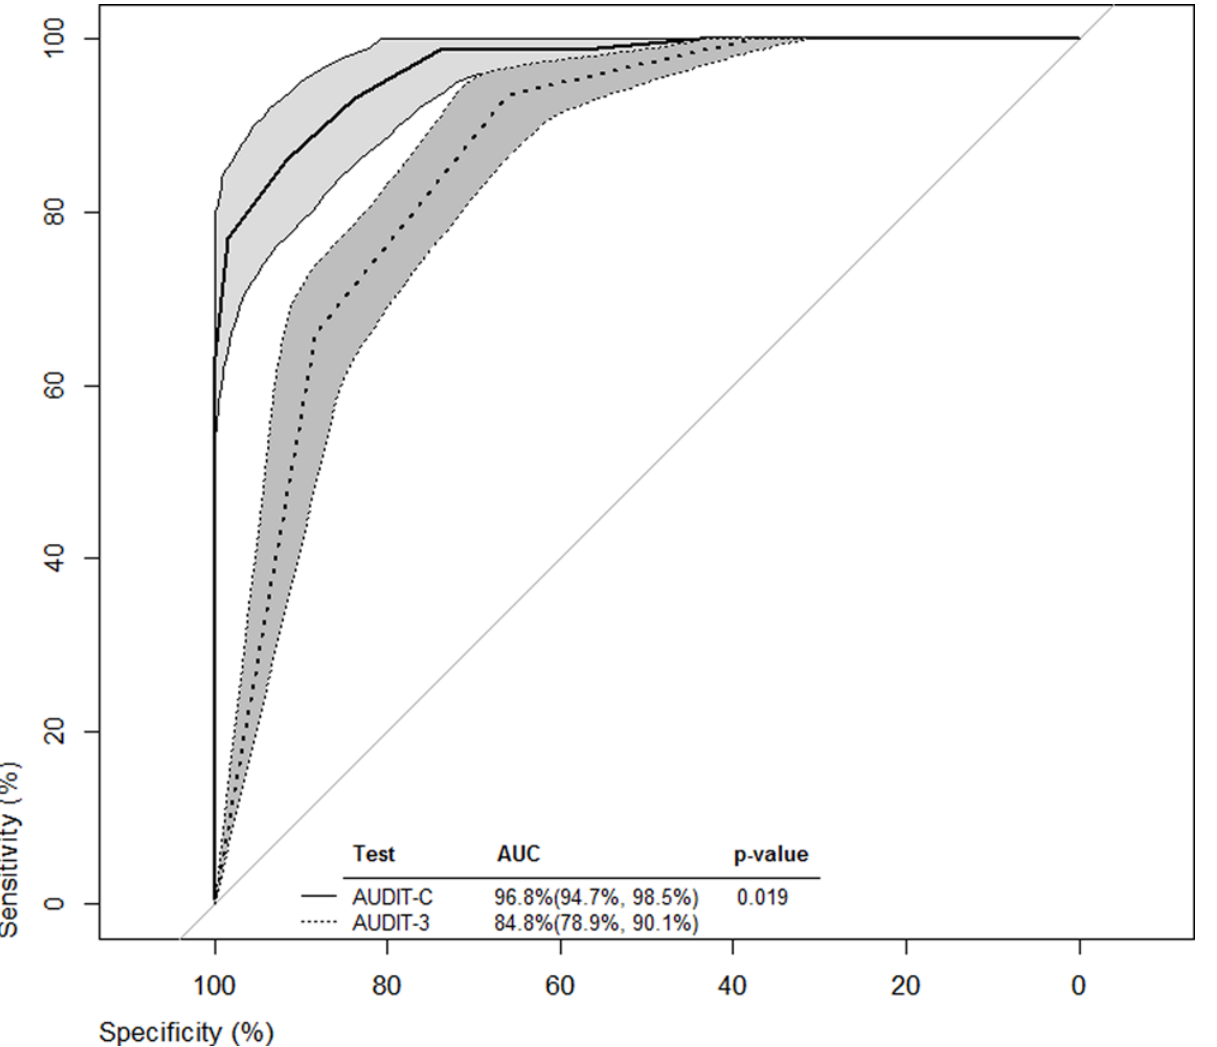
Fig 3. ROC curves for men from all cut-off values for both AUDIT-C and